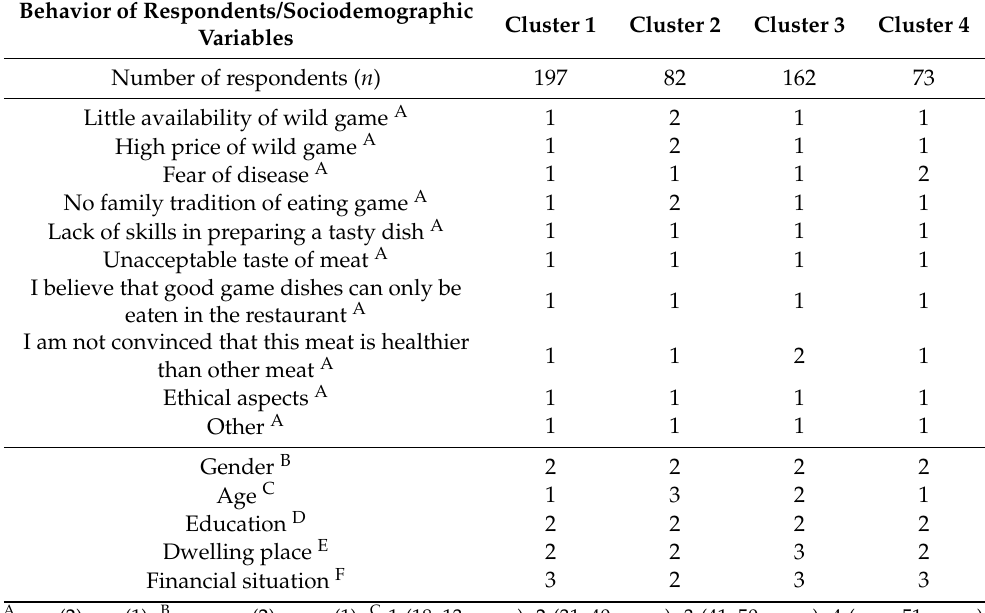
Table 5. Values of dominants and medians for variables describing the reasons for not consuming wild game and for sociodemographic